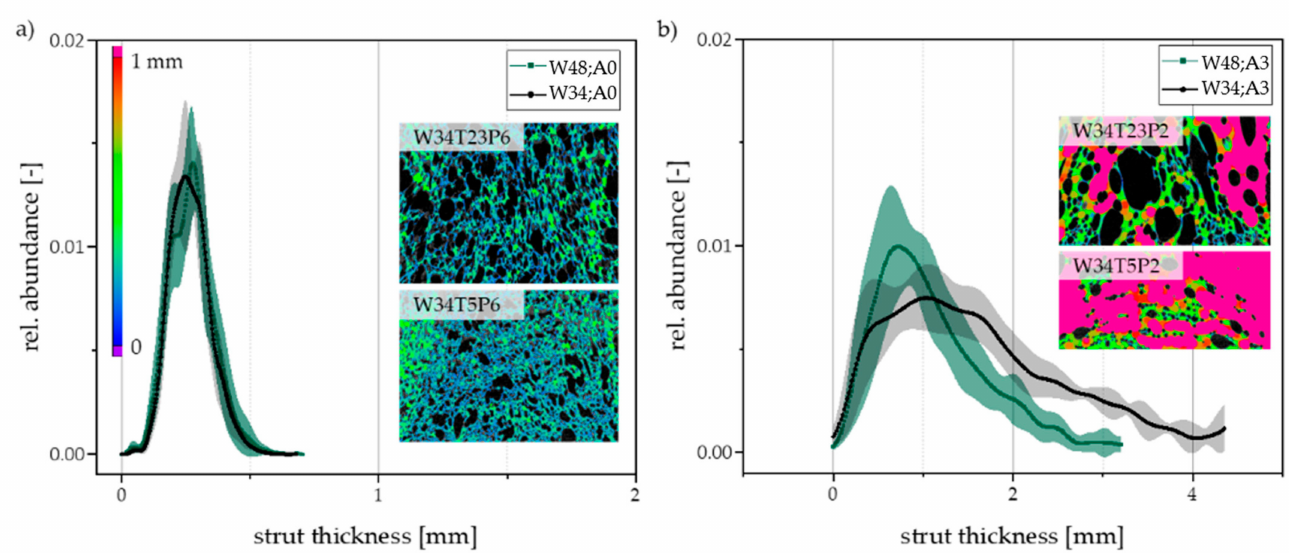
Figure 8. Relative abundance of the strut thickness for not-degassed ( a ) and degassed samples ( b